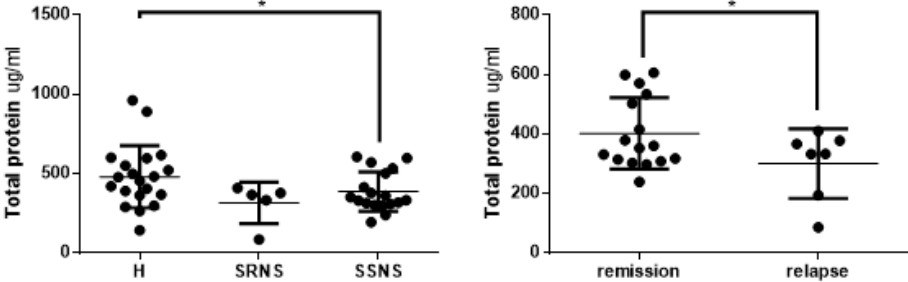
Figure 1. Total protein levels from the saliva of children with nephrotic syndrome and healthy controls. Samples from children with nephrotic syndrome were classified according to steroid-resistant nephrotic syndrome (SRNS) and steroid-sensitive nephrotic syndrome (SSNS); and according to the remission and relapse states. Total protein levels were quantified by a bicinchoninic acid assay. The values are presented as means and SD. * represents a statistically significant difference between the groups ( p = 0.04 for H/SRNS/SSNS; p = 0.036 for remission/relapse). Mean levels of the inflammatory markers examined were lower in the NS group than in the control group: 1136.23 pg/mL vs. 1913.89 pg/mL for IL-8 ( p < 0.05, Figure 2) and 124.04 pg/mL vs. 199.02 pg/mL for IL-6 (Figure 2). Stratifying the results according to remission and relapse states did not show statistically significant differences, though the mean IL-8 level was lower in the relapse than the remission group (Figure 2). Mean levels of IL1 β , IFN γ , and IL-4 were similar in the healthy, SRNS,